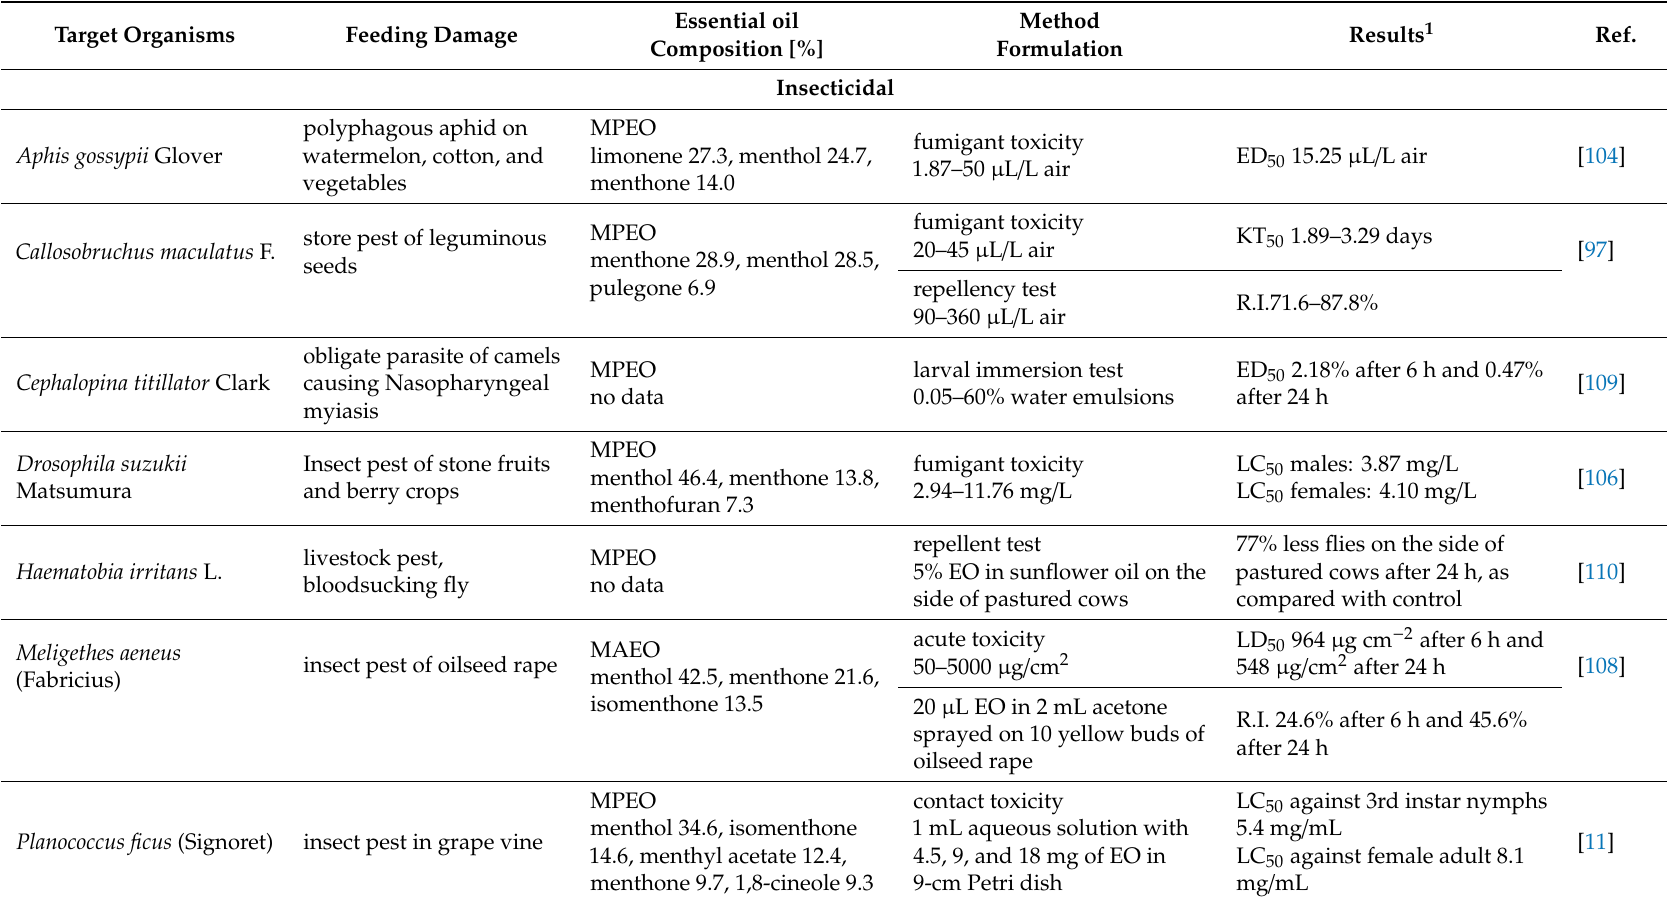
Table 3. Insecticidal and acaricidal action of peppermint oil and cornmint